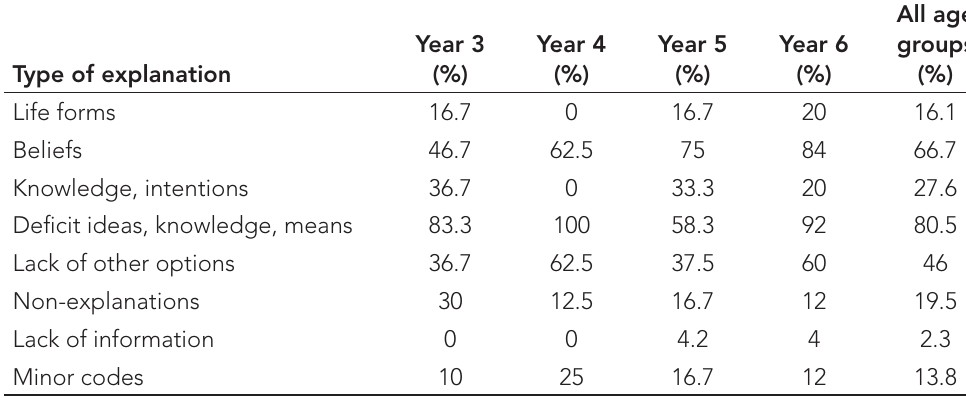
Table 2: Percentage of completed tasks containing references to a type of explanation, by age